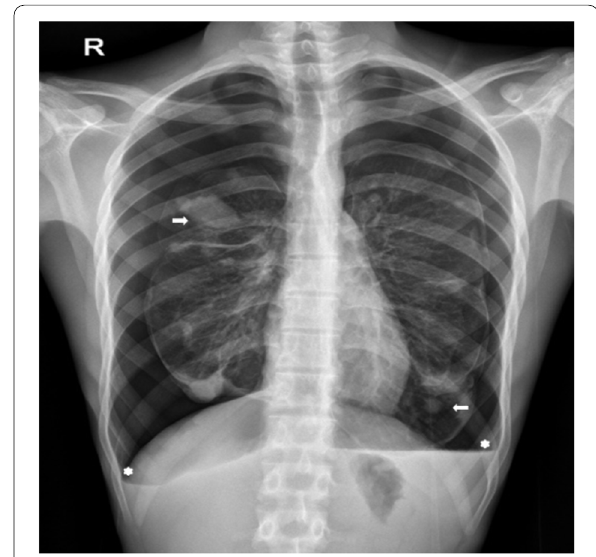
Fig. 6 Bilateral hydropneumothorax with pulmonary